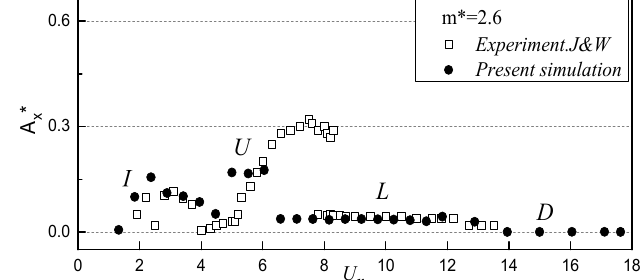
Figure 6. The trajectory of the cylindrical oscillator at different reduced velocities.